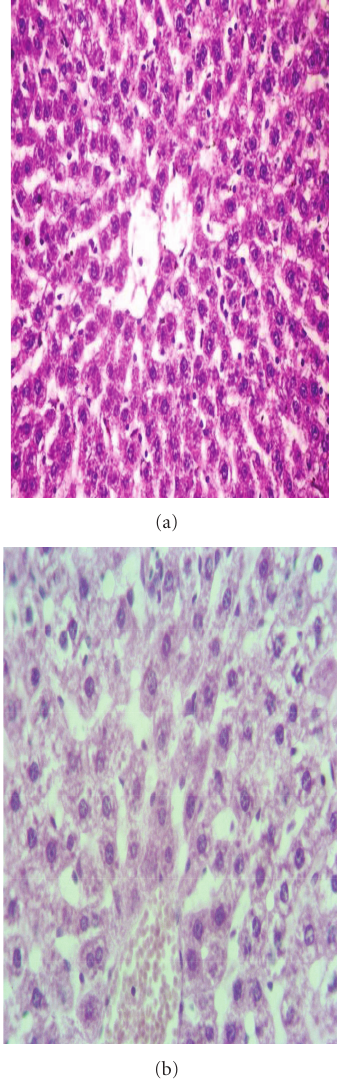
Figure 2: Sections in liver of rats treated with C. senna extract (b) at dose level of 500 mg/kg after 21 days of treatment relative to control